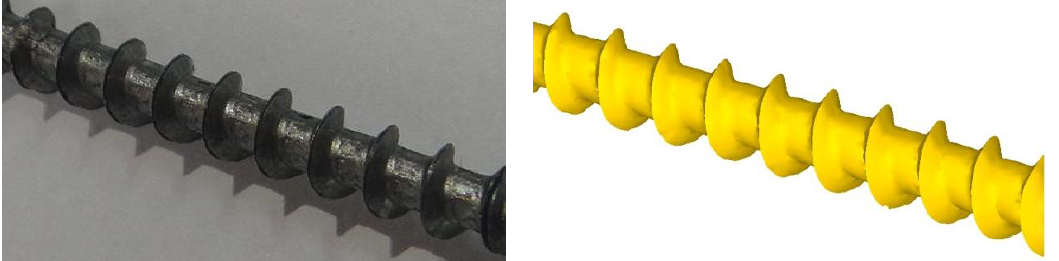
Figure 10. Simulated workpieces and actual sheet metal tapping screw.